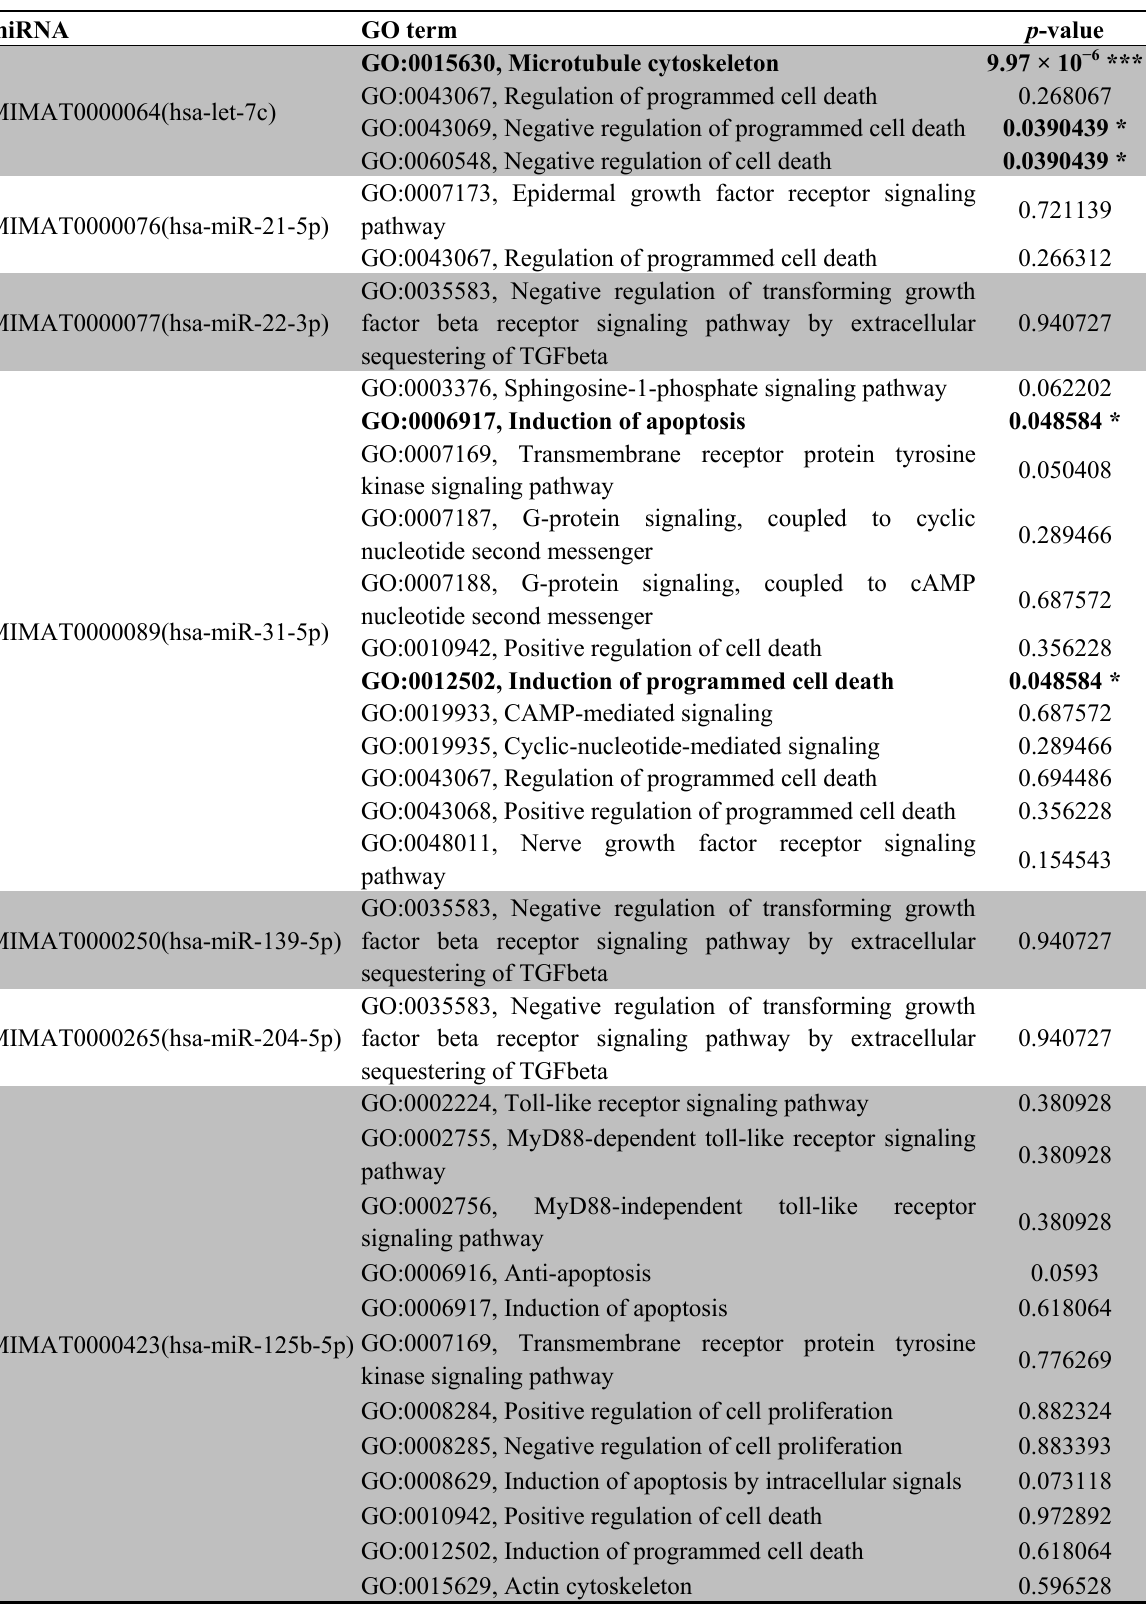
Table S7. GOBO survival analysis results. Genes which was annotated with the specified GO term of proteins in the PIN would be used as input gene set for GOBO analysis. * p < 0.05, ** p < 0.01; *** p <